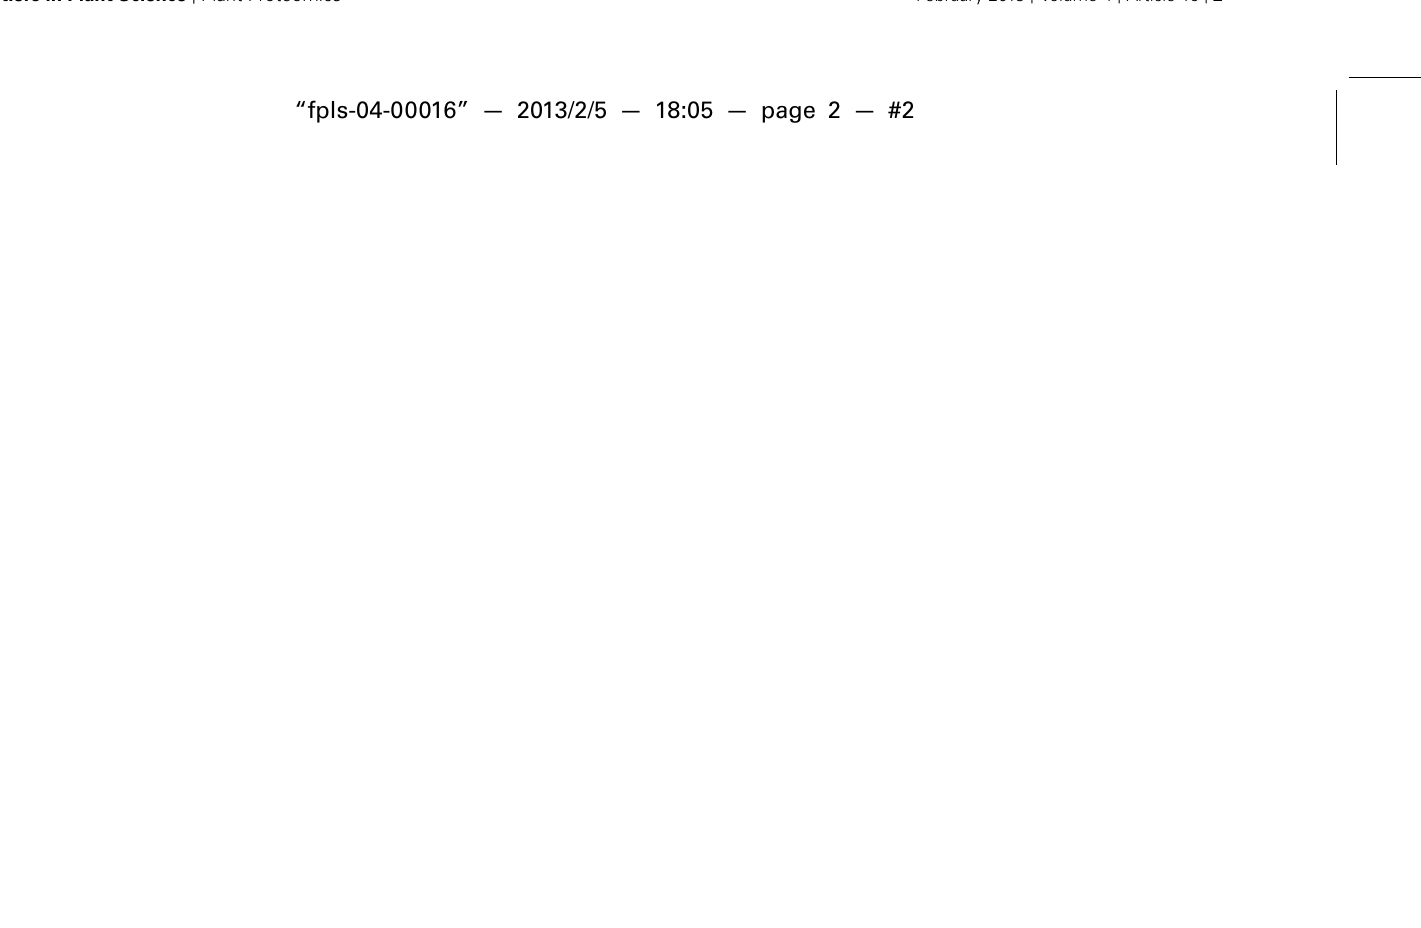
FIGURE 1 | Functional distribution of 322 identified rice mitochondrial proteins. Rice mitochondria were purified from 10-day-old dark-grown seedlings using differential and gradient centrifugation combined with surface charged ZE-FEE mode (Huang etal., 2009a). Rice mitochondria proteins were